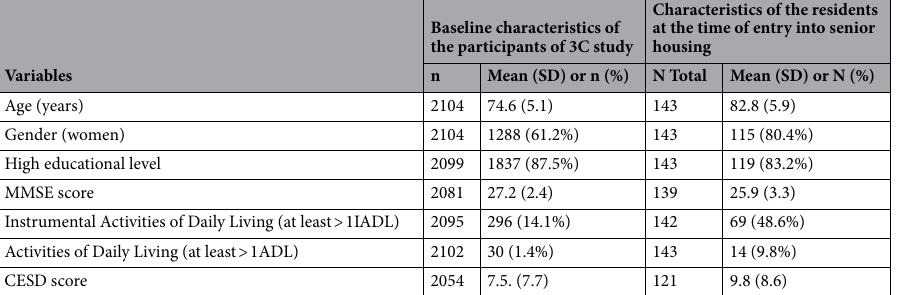
Baseline characteristics of the participants of 3C study